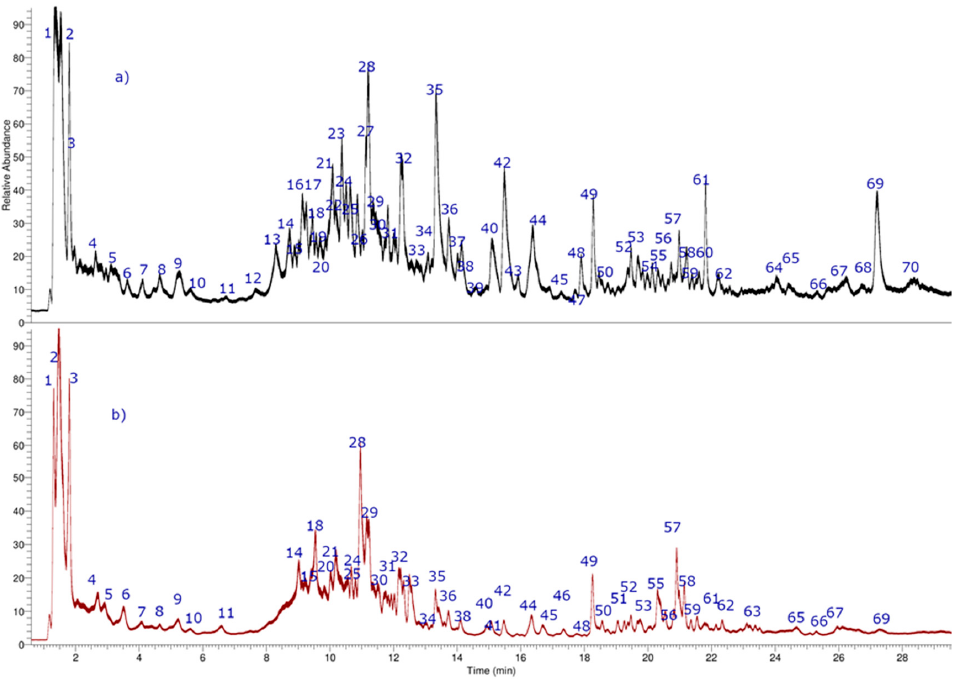
Figure 2. UHPLC chromatograms of G. sphacelata ( a ) pulp, and ( b ) seeds.